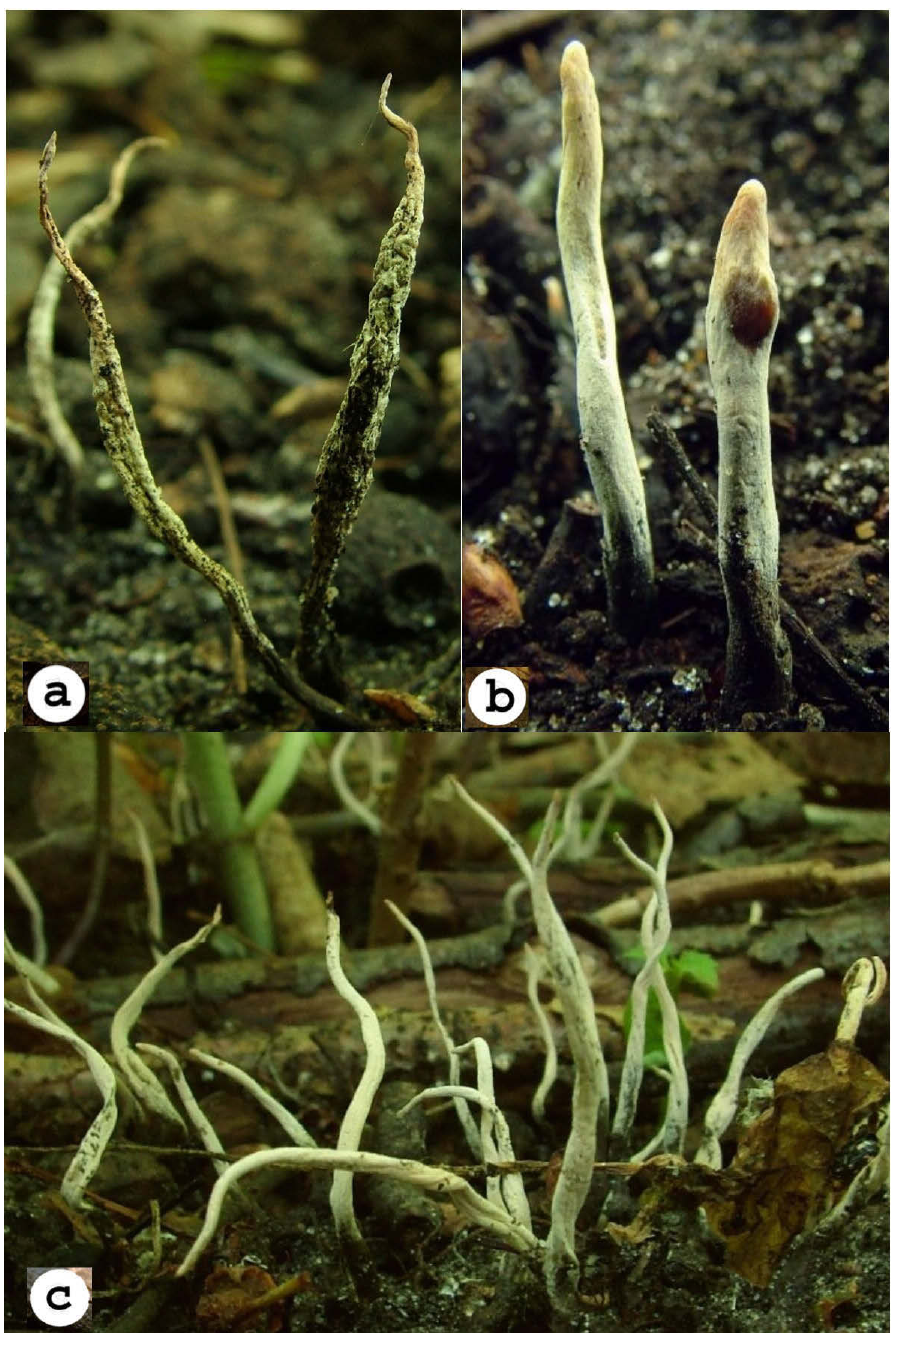
Fig. 1. Xylaria oxyacanthae – locality in Turew: a) teleomorphic stage; b) anamorphic stage; c) group of anamorphic stromata. Phot. K.